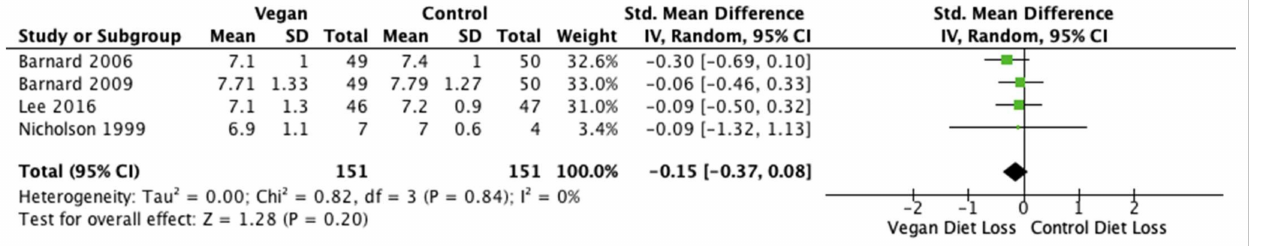
Figure 6. Forest plot comparing mean HbA1c levels after consumption of low-fat vegan and control diets